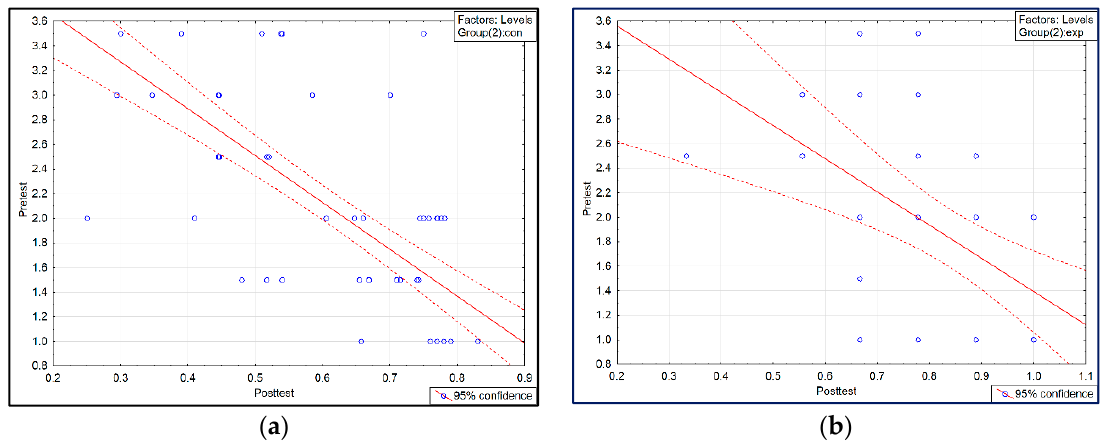
Figure 4. Scatter plot for the: ( a ) control group; ( b ) experimental group. The curves have the same slope, which means the regression coefficient is approxi- mately the same in both groups.